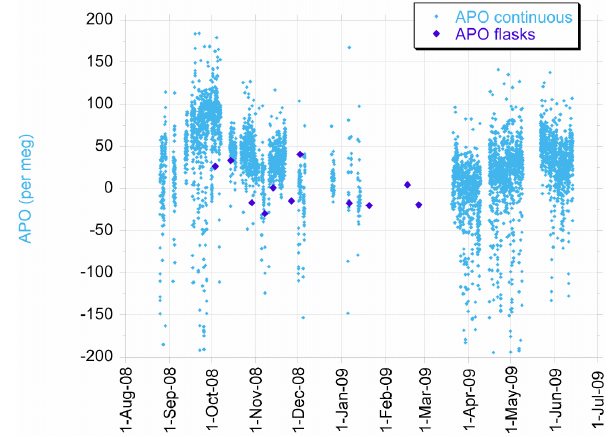
Fig. 9. Results of APO at the F3 platform for the period Au- gust 2008 through June 2009 showing the seasonal cycle as ex- pected during this period. The results for the continuous measure- ment system (smaller diamonds) are shown together with the results of the flask samples (larger diamonds). The amplitude of the sea- sonal cycle of APO is around 75permeg, and is composed of the oceanic APO seasonality and is also influenced by the fossil fuel combustion